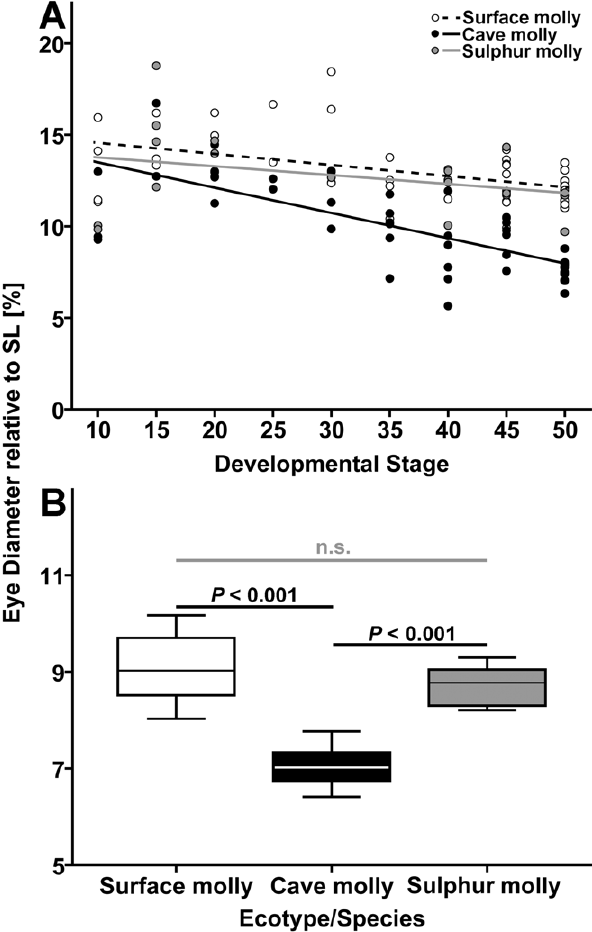
Figure 6. Relative head length in three types of mollies. ( A ) Scatter plots showing the ‘head length to SL’ ratio vs. stage of development in molly embryos from one benign and two extreme habitats. Stages 0, 2 and 5 are not depicted, because they lack a differentiated head. ( B ) Box plots (median and IQR) for the head length to SL ratio in adult fish ( N =10 per population). P -values refer to Fisher’s LSD post hoc tests. Test statistics for both graphs are presented in the results section.